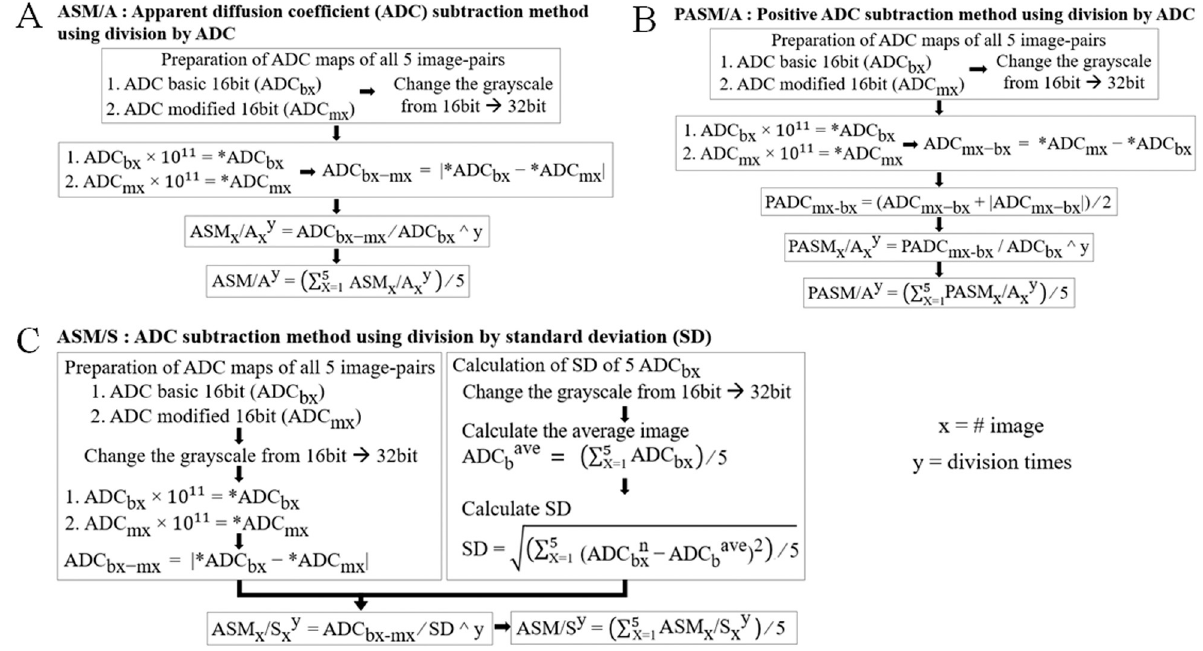
Fig 1. Calculation processes of the three types of ASM image. (A) ASM/A is an image indicated by the absolute difference between two ADC values, ADC b and ADC m , divided by ADC b � five times. (B) PASM/A is an image indicated by the positive values of the difference between the two ADC values, which is deduced by subtracting ADC b from ADC m , divided by the ADC b value � five times. (C) ASM/S is an image indicated by the absolute difference between the ADC values, ADC b and ADC m , divided by the SD image. ADC, apparent diffusion coefficient; ASM, ADC subtraction method, ADC b , ADC basic; ADC m , ADC modify; PASM/A, positive ASM; SD, standard deviation; S, SD image.